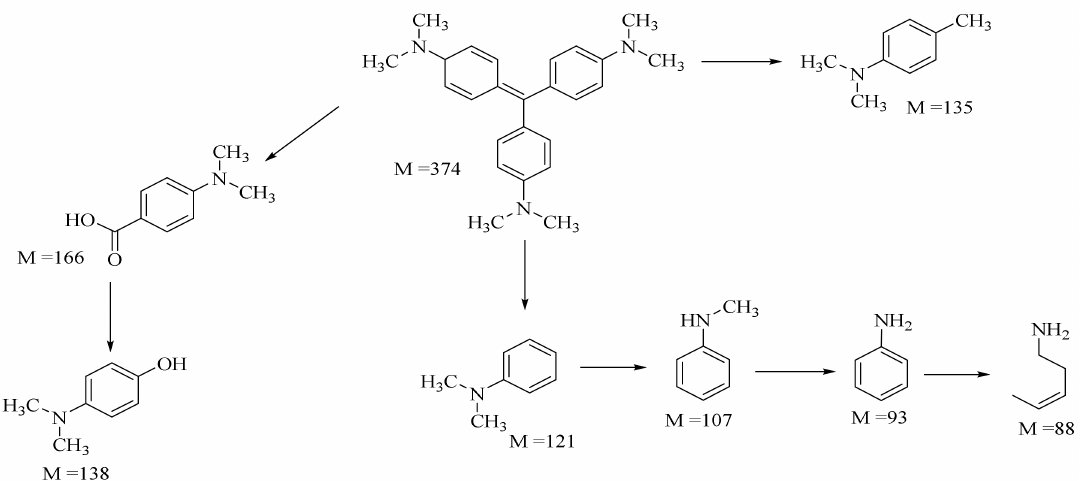
Scheme 2. Degradation pathway of crystal violet over CuS nanoparticles.